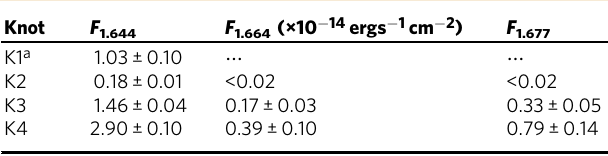
Table 2 [Fe II] lines observed in the various knots